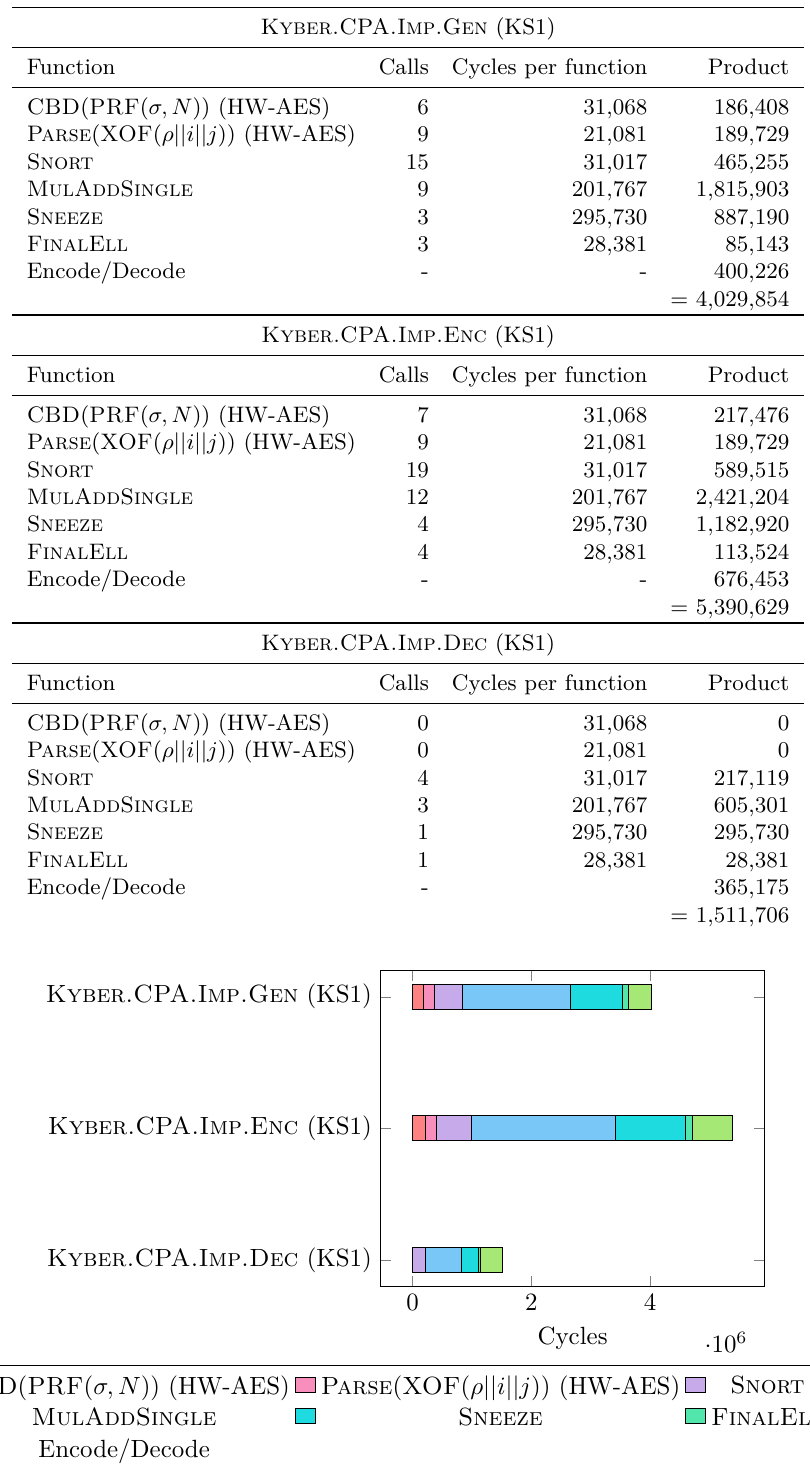
Figure 1: Total cycle counts per function from Table